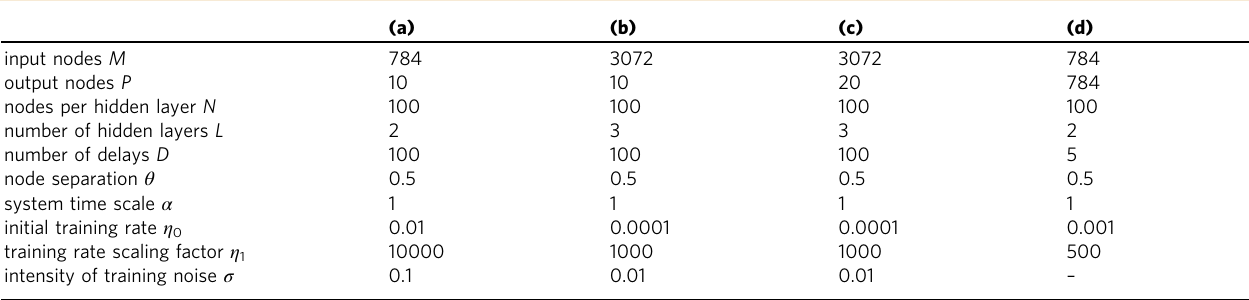
Table 1 Default